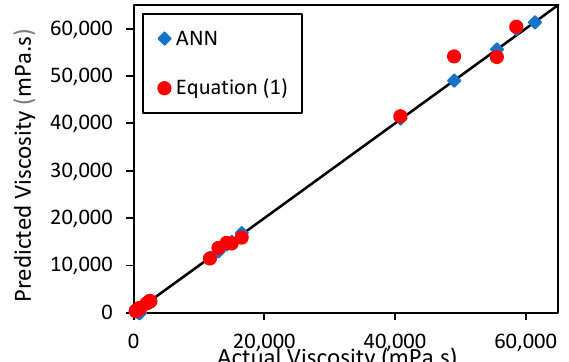
Figure 4. A plot of the experimental against the predicted bitumen viscosity using both Equation (1) and the ANN .